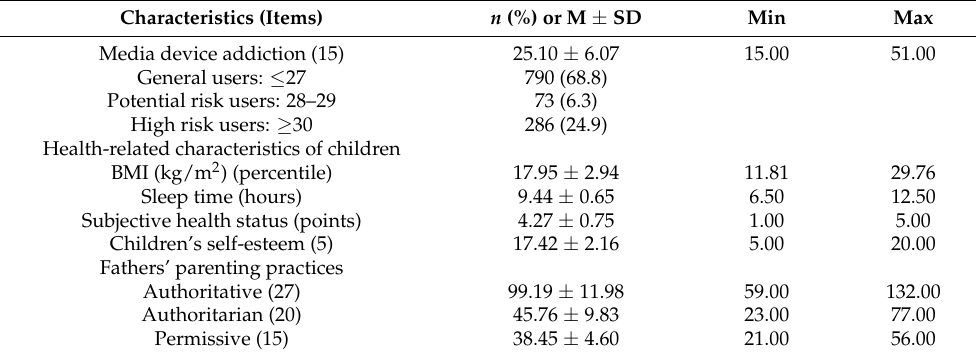
Table 2. Children’s media device addiction levels, self-esteem, and fathers’ parenting practices (N = 1149).